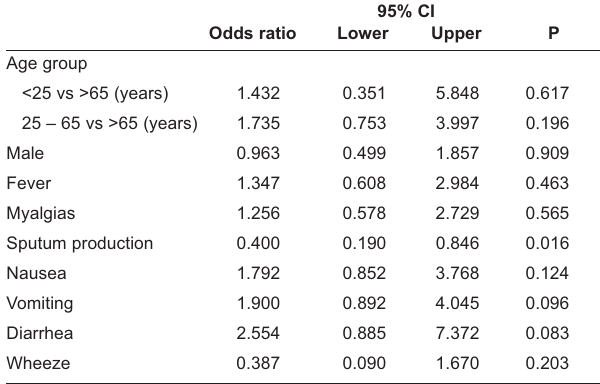
TABLE 5 Multivariate analysis of factors that predict a positive blood culture in ambulatory patients with community- acquired pneumonia